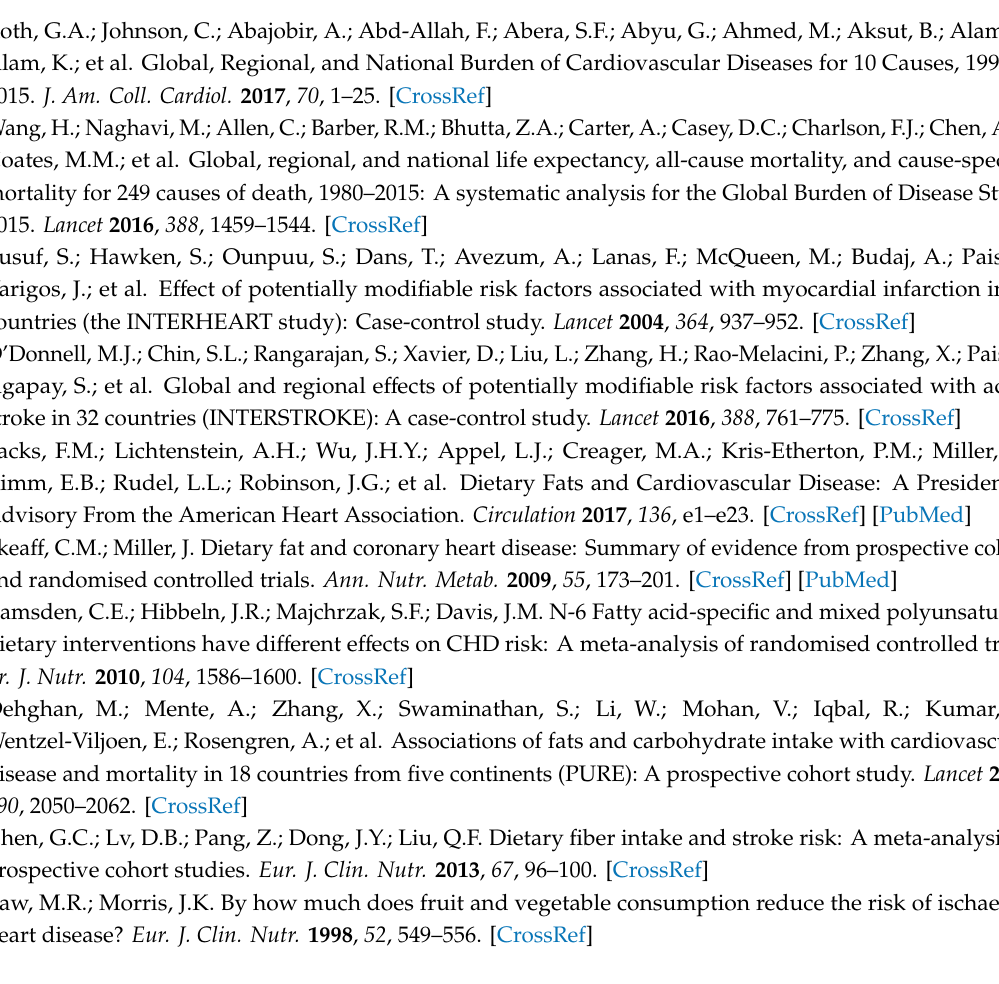
Table S3: Pooled risk ratios of dietary factors, according to outcomes. Table S4: Results of methodological quality